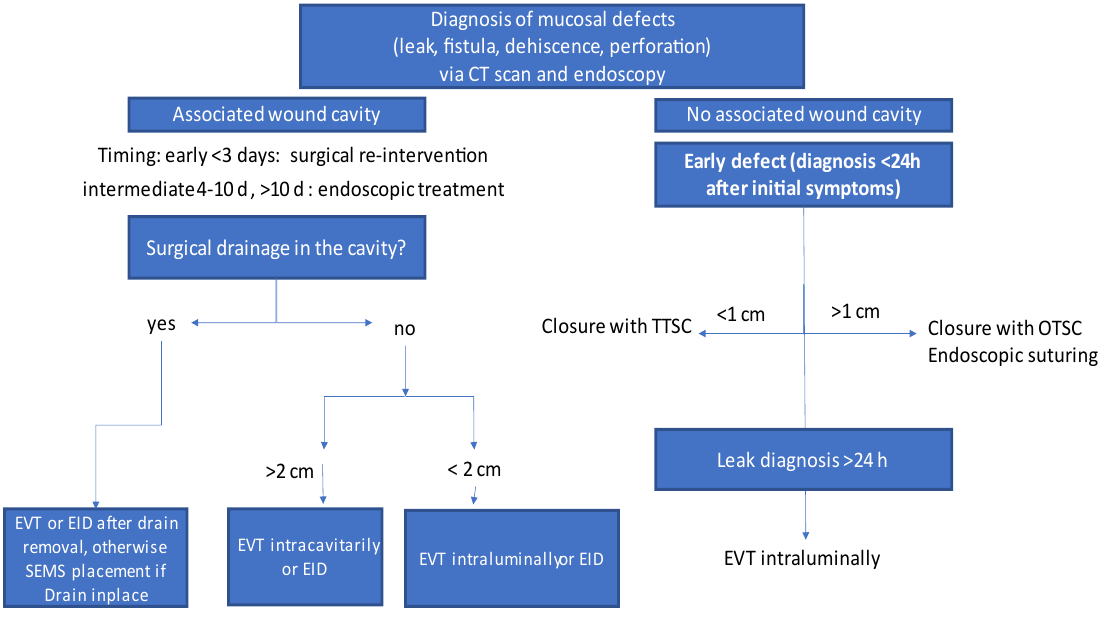
Figure 3. Flowchart treatment of mucosal defects in the upper GI tract, modified after Loschke and Di Leo et al. [15,103]